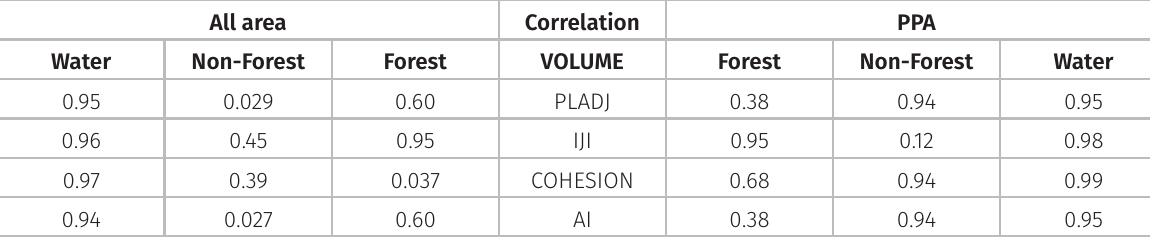
Figure 4. Var iation of form metrics along landscape, where a) proximity index – PROX_MN and b) Euclidian distance – Table VI. Correlation between Serra Azul reservoir volume and cohesion landscape metrics throughout the study region and in the permanent preservation areas.